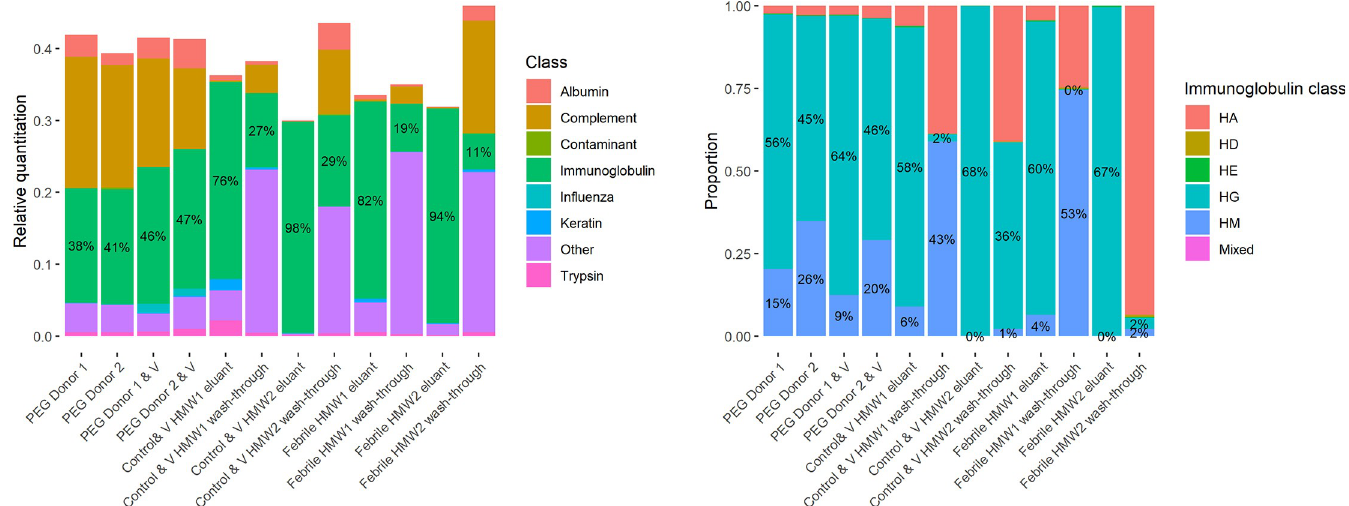
Fig 5. Quantification of different protein classes and identification of immunoglobulins. V indicates samples to which influenza vaccine was added. HMW1 refers to the highest molecular weight peak and HMW2 refers to the second peak. Febrile HMW1 eluant, wash-through and Febrile HMW2 eluant and wash-through are not spiked with vaccine. (A) Relative quantities of different classes of protein as calculated through a modified iBAQ-based approach. The total height of each bar is the proportion of MS1 intensity belonging to each identified feature. Samples come from two donors (Donor 1 and Donor 2). (B) Proportion of immunoglobulin mass by class as estimated using a modified iBAQ-based approach and extrapolated from constant peptides only. HA: IgA heavy chain, HD: IgD heavy chain, HE: IgE heavy chain, HG: IgG heavy chain and HM: IgM heavy chain.